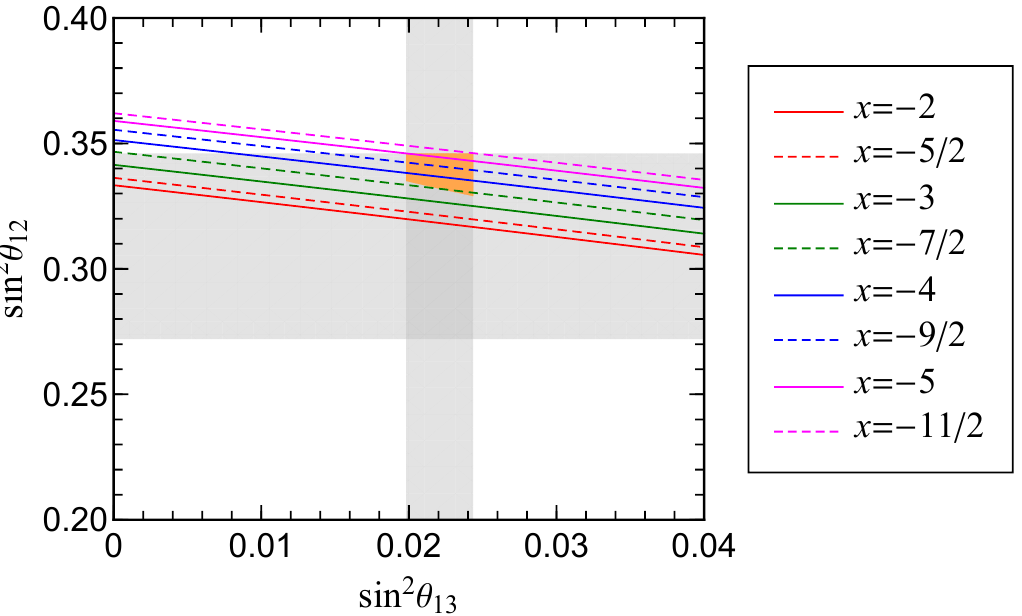
Figure 2 . Correlation between sin 2 (cid:18) 12 and sin 2 (cid:18) 13 given by eq. (4.23) for various values of x . The gray bands represent the experimentally preferred 3 (cid:27) ranges of sin 2 (cid:18) 13 and sin 2 (cid:18) 12 adapted from [4]. The orange area denotes the most generally allowed regions of sin 2 (cid:18) 13 and sin 2 (cid:18) 12 in the new Littlest seesaw model, where the four input parameter m a , m s , (cid:17) and x are randomly chosen and the resulting mixing angles and mass squared di(cid:11)erences are required to lie in the experimentally preferred 3 (cid:27) regions